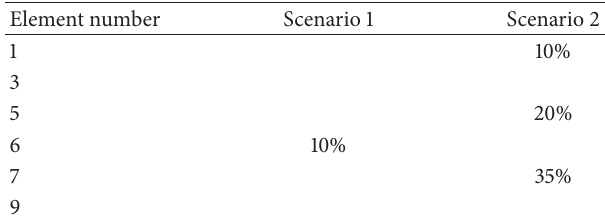
Table 1: Simulated damage scenarios in cantilever